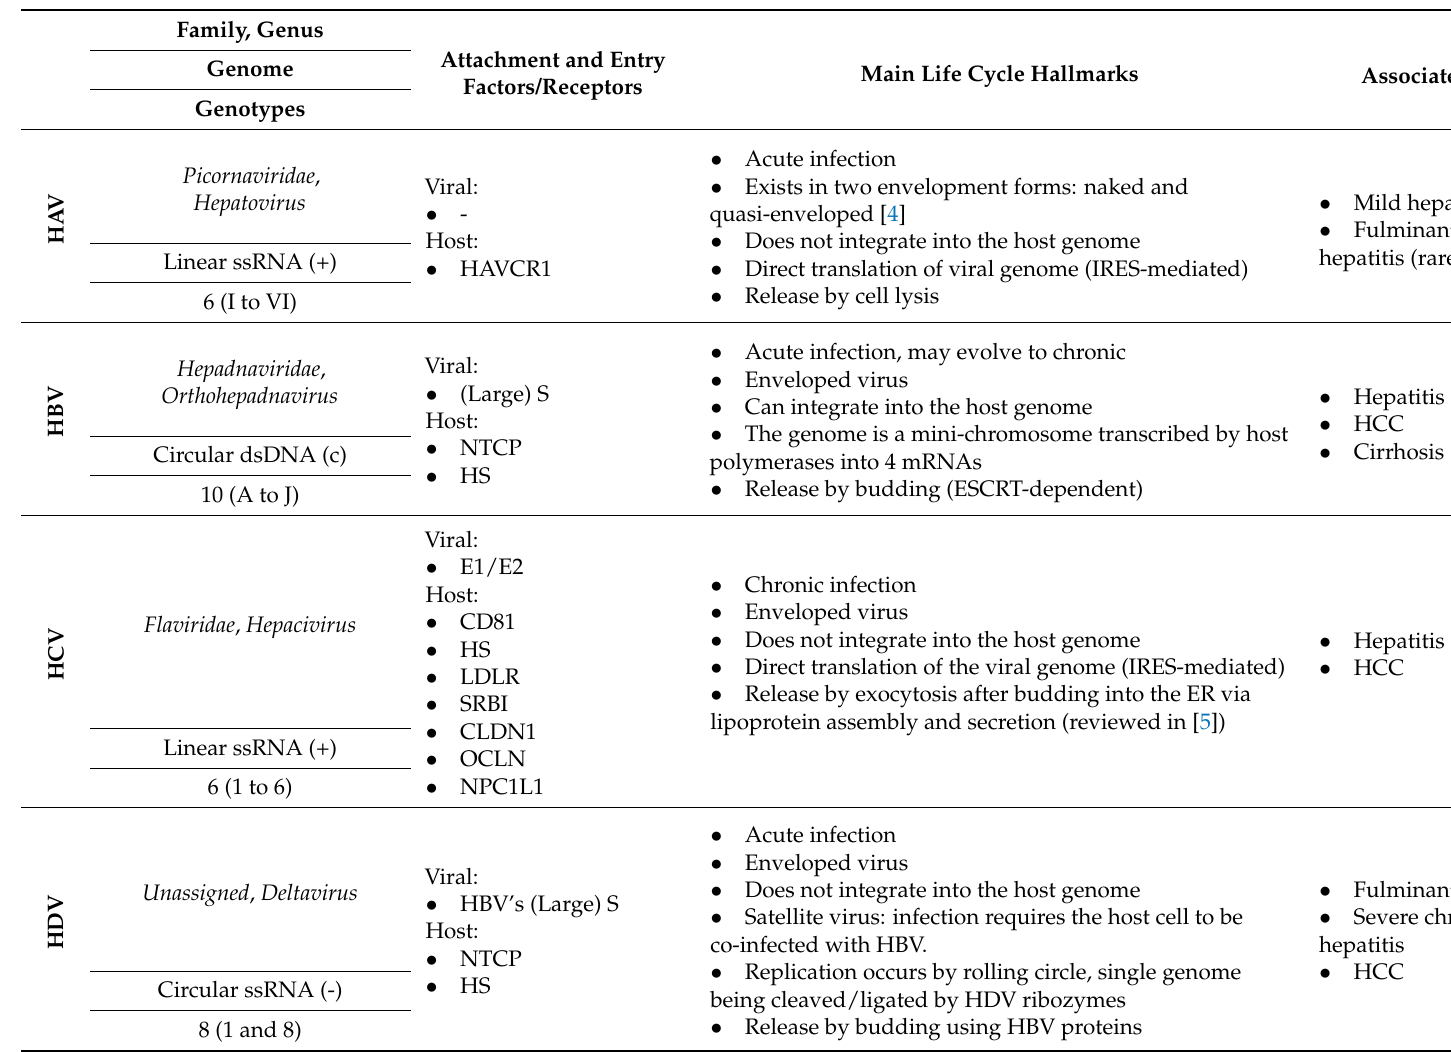
Table 1. Overview of hepatitis viruses a